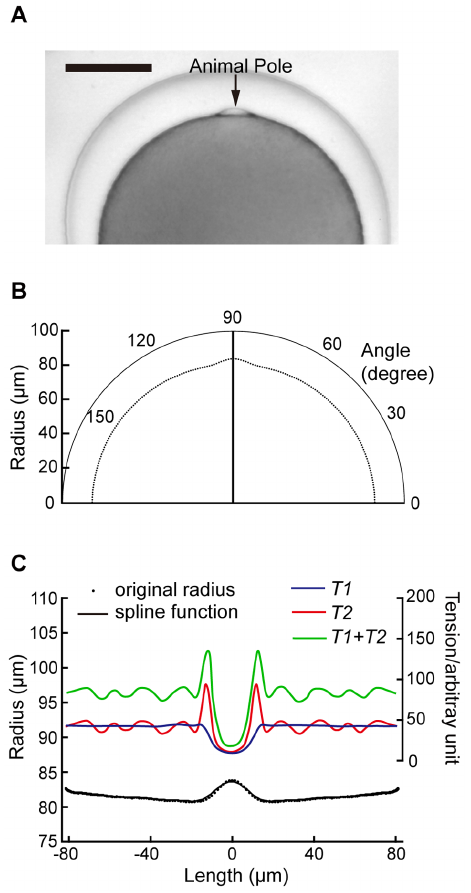
Figure 2. Procedure of fine estimation of tension at the surface of the animal hemisphere. (A) Image of the animal hemisphere of an oocyte at high resolution. Scale bar, 50 m m. (B) The outline curve in the animal hemisphere expressed in polar coordinates. (C) Tensions at the surface in the animal hemisphere and the radius of the oocyte versus the distance along the cord, vertical to the animal vegetal axis. The spline function accurately fits the radius of the original outline curve.